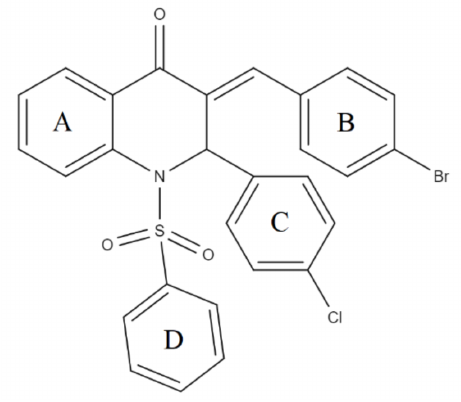
Figure 2. Structural formula of QBCP. Table 1. Experimental details of QBCP.